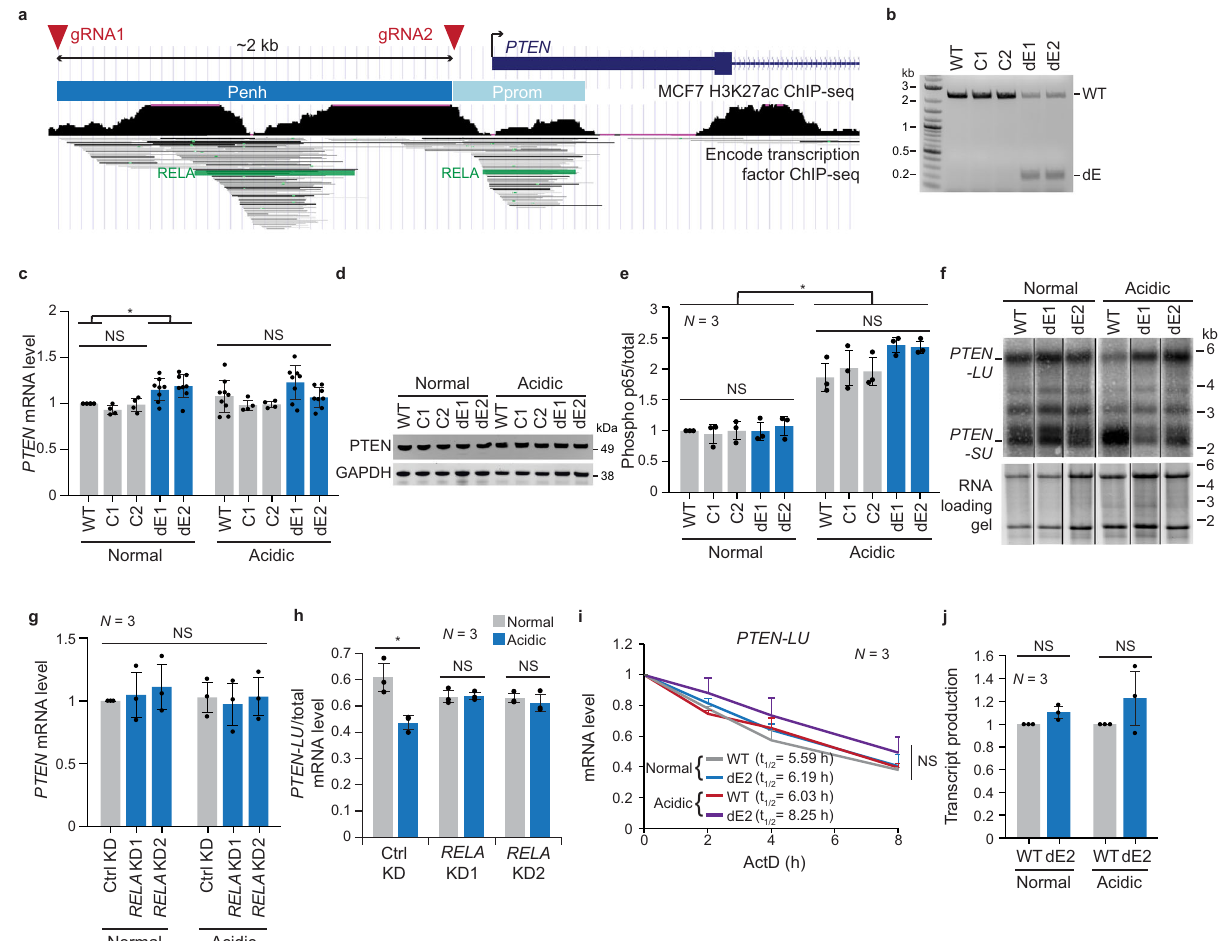
Fig. 1 The PTEN enhancer induces a 3 ′ UTR isoform switch of endogenous PTEN . a UCSC genome browser snapshot showing the PTEN genomic locus around the transcriptional start site (arrow). The PTEN enhancer (Penh) was deleted using the indicated guide RNAs (red arrow heads). Among transcription factor binding sites identi fi ed by ChIP-seq, RELA binding sites are highlighted. PTEN promoter, Pprom. b Genotyping PCR was performed in parental MCF7 cells (WT), wild-type clones (C1, C2), and heterozygous enhancer deletion clones (dE1, dE2) with a primer pair fl anking the deleted region. Shown is an agarose gel with the indicated PCR products. n = 3 biologically independent experiments. c PTEN mRNA expression measured by RT-qPCR in the indicated samples. Data are shown as mean ± std. of n = 4 biologically independent experiments for C1 and C2 and n = 8 biologically independent experiments for WT, dE1, and dE2 after normalization to RPL19 . One-way ANOVA with Tukey ’ s post-hoc test was performed. * P = 0.0048 between WT and dE1 and P = 0.0015 between WT and dE2; NS, not signi fi cant. d Representative western blot showing steady-state PTEN protein levels in the indicated samples. GAPDH serves as loading control. n = 3 biologically independent experiments. e Steady-state levels of phosphorylated p65 (S536) and total p65 were determined by western blot for the indicated samples and normalized to the levels of WT in the normal condition. The fraction of phosphorylated p65 over total p65 is shown as mean ± std of n = 3 biologically independent experiments. One-way ANOVA with Tukey ’ s post-hoc test was performed. * P = 5 × 10 − 9 ; NS not signi fi cant. f Representative northern blot showing PTEN mRNA isoforms in the indicated samples. The RNA gel is shown as loading control. SU short 3 ′ UTR; LU long 3 ′ UTR. n = 3 biologically independent experiments. g As in (C), but for ctrl KD and RELA KD samples. Data are shown as mean ± std of n = 3 biologically independent experiments. One-way ANOVA was performed. NS not signi fi cant. h Steady-state levels of PTEN-LU and total PTEN mRNA were measured by RT-qPCR in the indicated samples. The fraction of PTEN-LU over total PTEN mRNA is shown as mean ± std of n = 3 biologically independent experiments. Two-tailed t-test for independent samples was performed. * P = 0.0156; NS not signi fi cant. i Quanti fi cation of PTEN- LU mRNA expression at four time points after inhibition of transcription with actinomycin D (ActD) in the indicated samples. The values were obtained by RT-qPCR, normalized to the 0 h time point and are shown as mean ± std of n = 3 biologically independent experiments. Half-life (t 1/2 ) of PTEN-LU mRNA is shown for each sample. One-way ANOVA was performed at each time point. NS not signi fi cant. j Metabolic labeling with 4-thiouridine (4sU) was used to enrich newly transcribed mRNAs. The newly transcribed RNAs were thiol-alkylated and biotinylated, followed by Streptavidin pull-down. The fraction of newly transcribed over total PTEN transcripts is shown for the indicated samples and was measured using RT-qPCR with a primer pair in the fi rst intron. Data are shown as mean ± std of n = 3 biologically independent experiments. Two-tailed t -test for independent samples was performed. NS not signi fi cant. Source data for fi gures ( b – j ) are provided as a Source Data fi